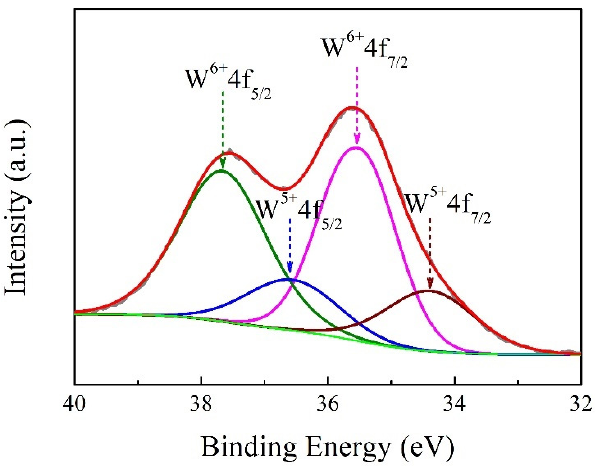
Figure 5. Tungsten core-level (W 4f ) XPS spectra of the Na x WO 3 nanoparticles with Na/W ratio of 1:1.